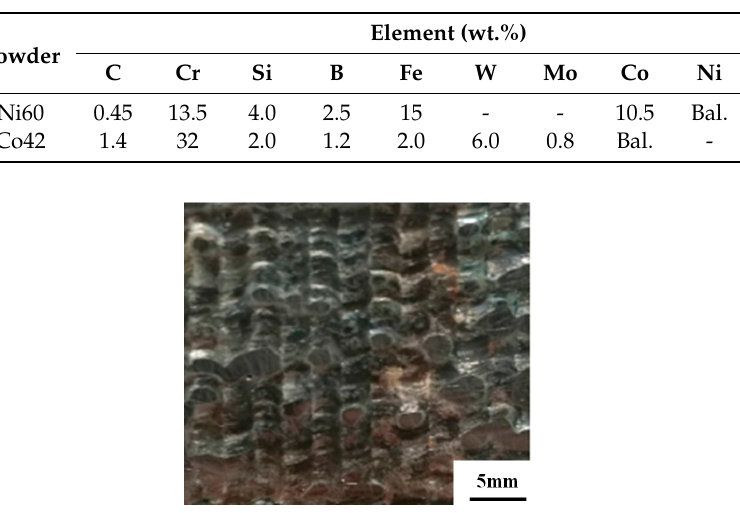
Figure 1. Macroscopic morphology of cladding coating.